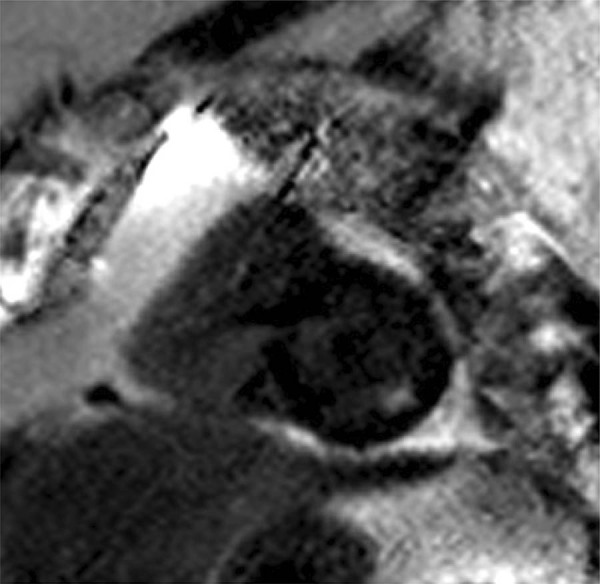
–
Short- axis delayed contrast-enhanced PSIR cardiac MR image, demonstrating focal subendocardial and subepicardial enhancement areas localized into the inferior and inferolateral left ventricular walls.